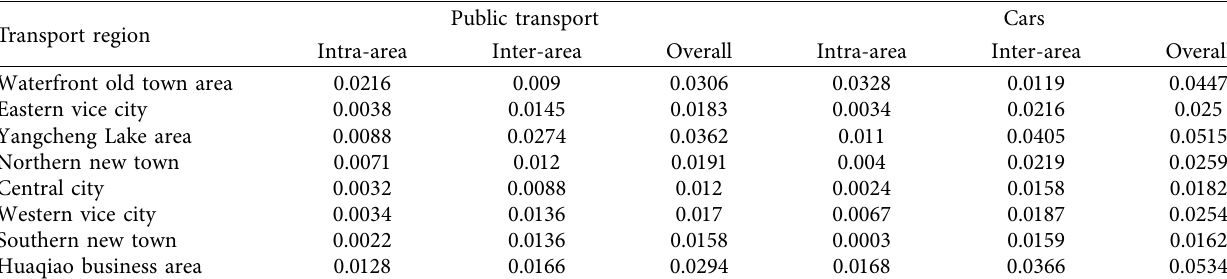
Table 7: Public transport and car accessibility in Kunshan Theil